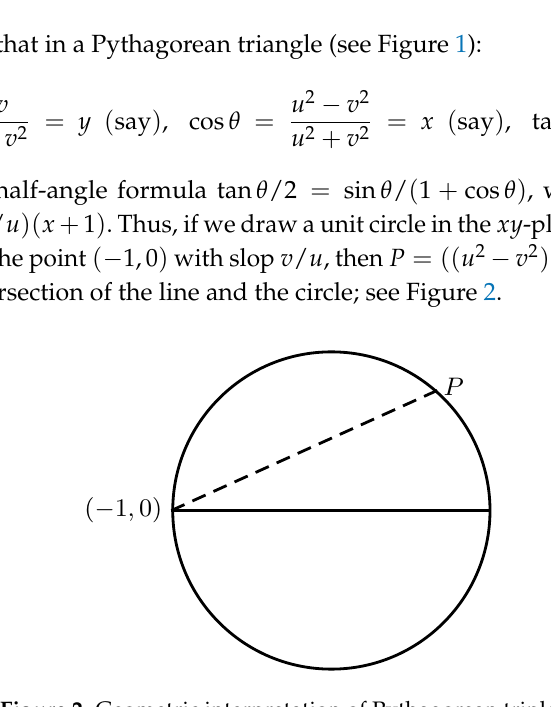
Figure 2. Geometric interpretation of Pythagorean